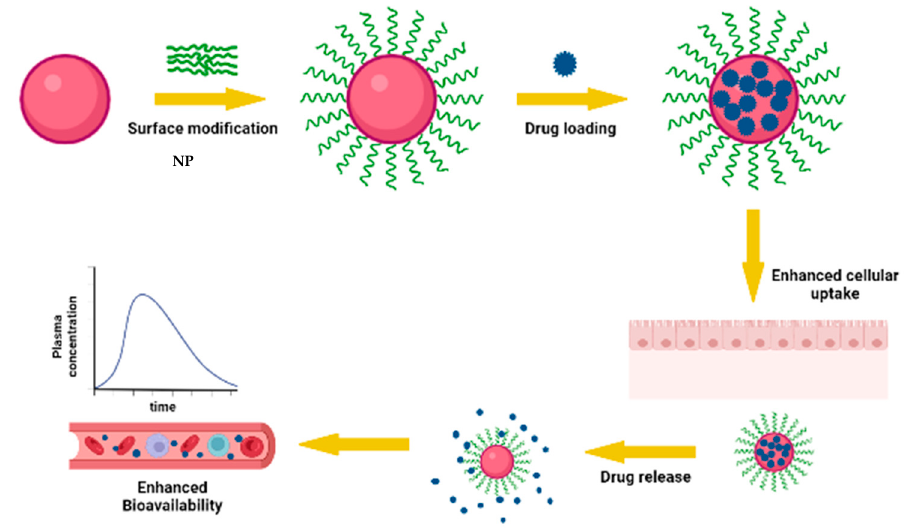
Figure 3. Enhanced bioavailability of AmpB nanoformulation offered by surface modifications.